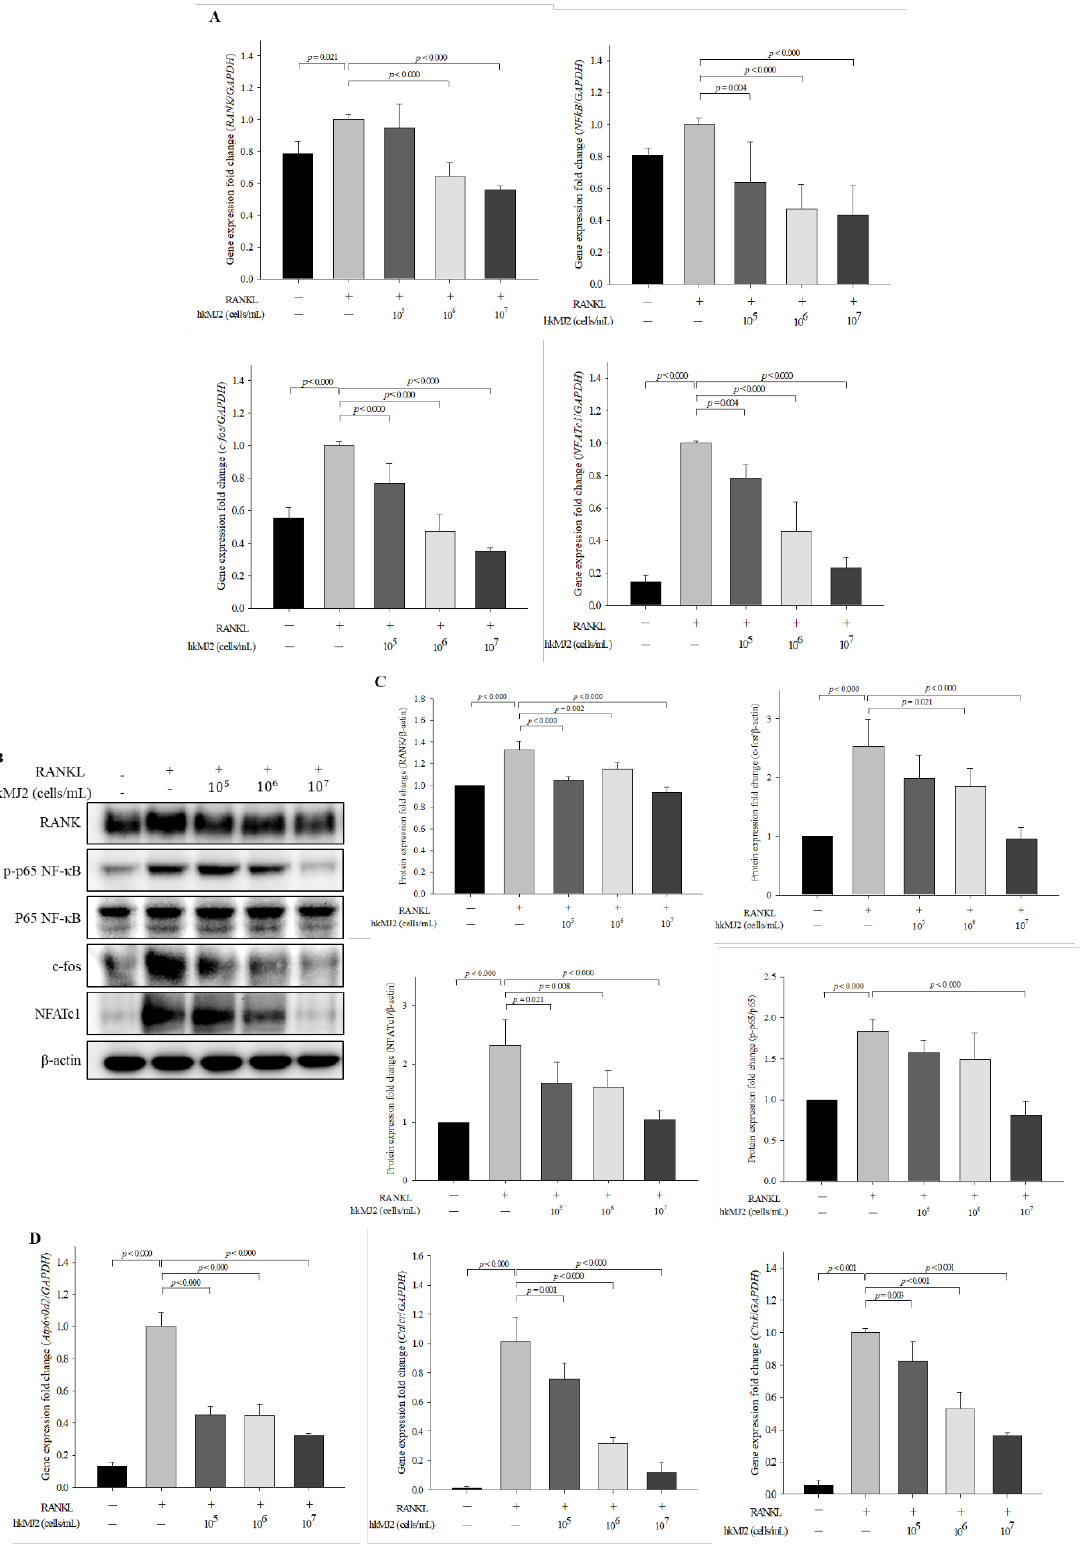
Figure 3. Effects of hkMJ2 on the expression levels of osteoclast differentiation-related genes and proteins in the RANKL-induced cells. The expression levels of RANKL-induced osteoclastogenic genes were measured by qPCR ( A ) and proteins were measured by western blotting ( B ) and quantified ( C ). The expression levels of NFATc1-downstream genes were measured by qPCR ( D ). The values indicate the mean ± standard deviation (SD) of three independent experiments performed in triplicate. NFATc1, nuclear factor of activated T-cells cytoplasmic 1; RANKL, receptor activator of